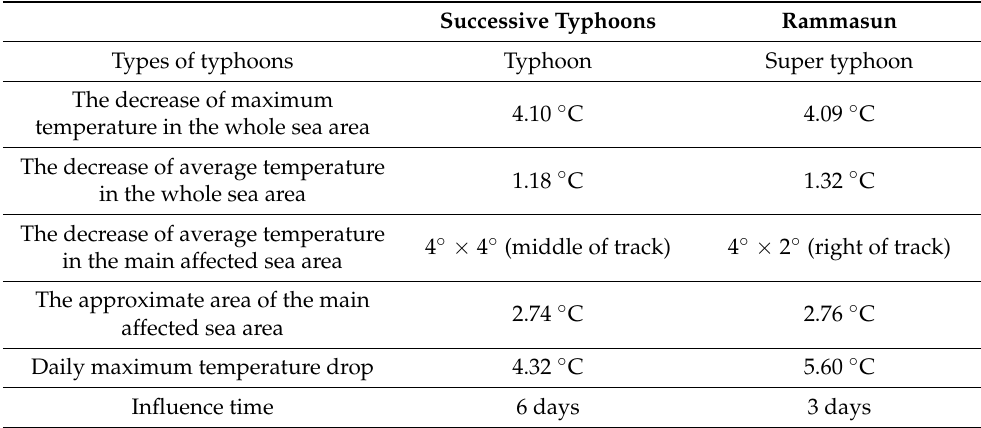
Table 2. SST responses to successive typhoons and